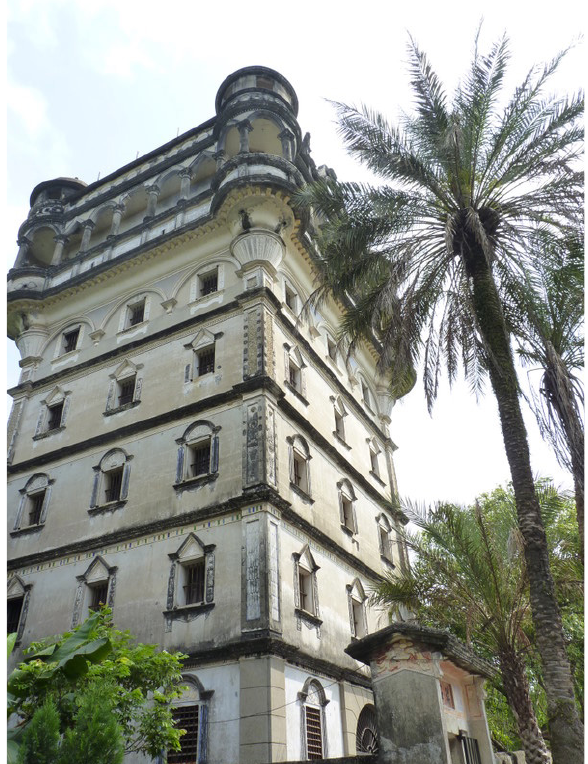
Figure 9. Ruishi Lou in Jinjiangli village (source: field